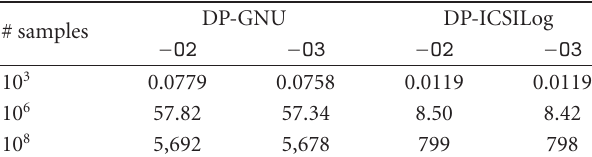
Table 10: Execution times (in ms) of GNU and ICSILog DP implementations compiled with gcc and − O2 / − O3 .